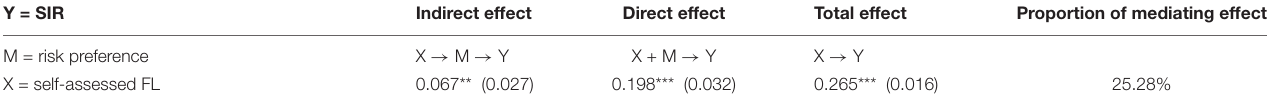
Panel B: The test results of mediating